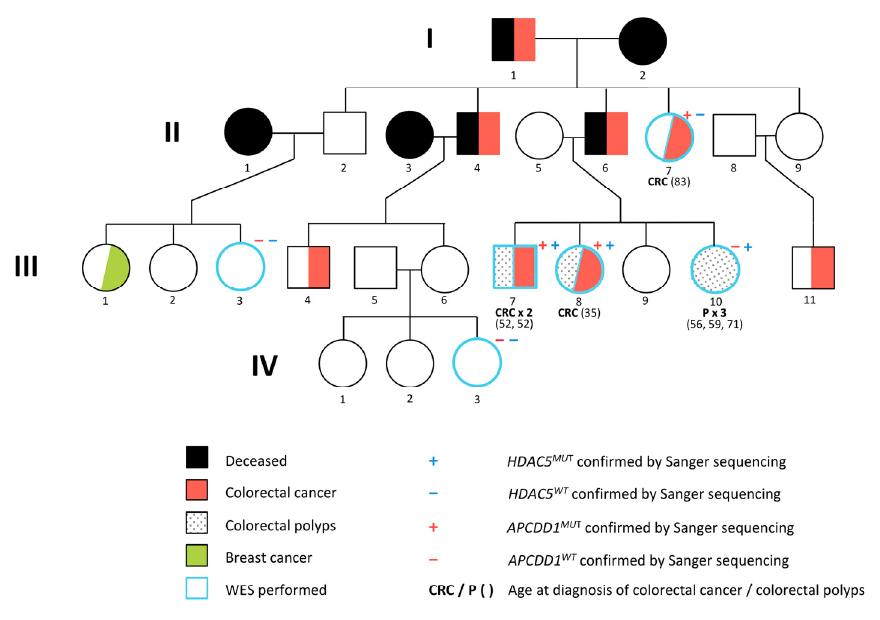
Figure 1. Pedigree of the CRC (colorectal cancer) family with APCDD1 and HADC5 variants analyzed in this study.